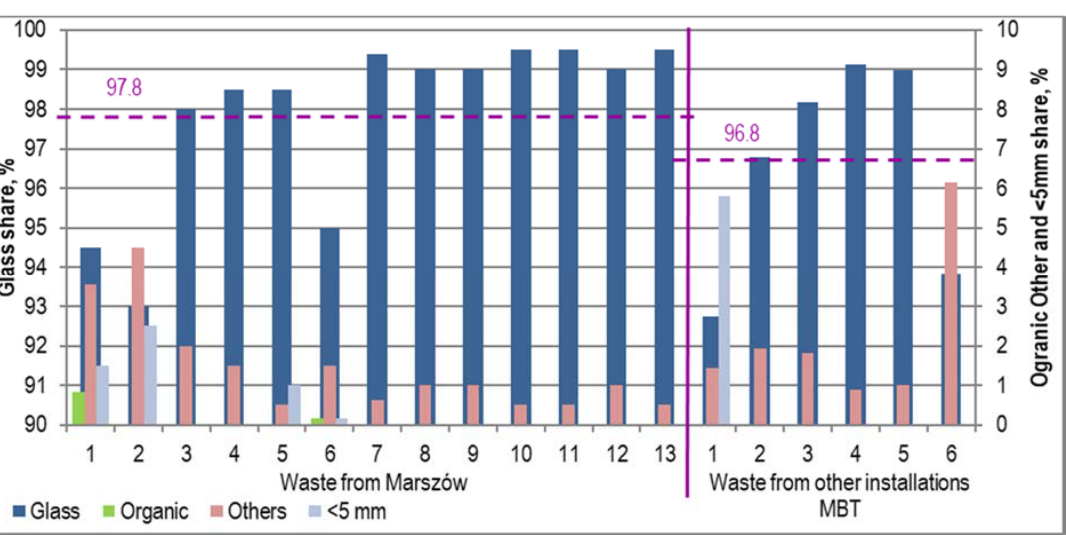
Figure 7. Composition of glass concentrates produced on the process line.